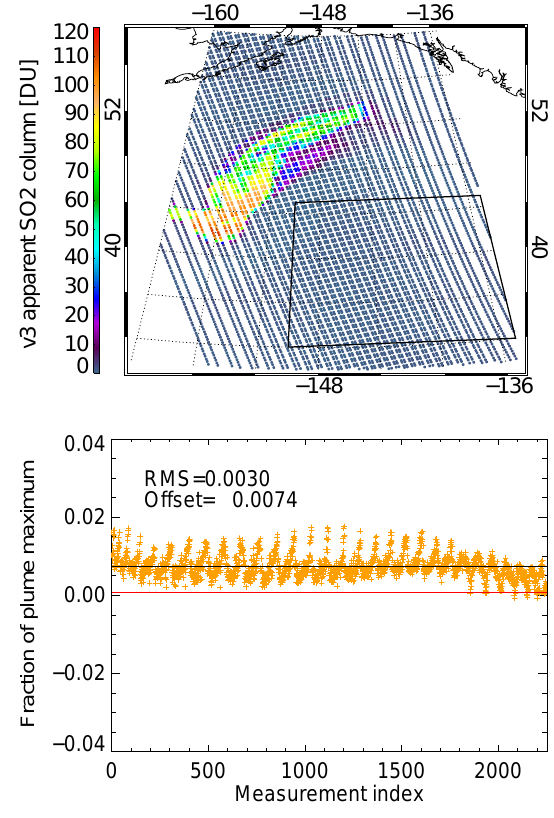
Fig. 5. The plume of SO 2 for the morning overpass on 10 Au- gust 2008 using the ν 1 band filter for Method (2) as described in the text using the ensemble approach to compute S tot (cid:15) . Fractional varia- tion in the background normalised according to the maximum value within the plume (328DU) shown in the bottom panel for IFOV’s inside box. Reported 1 σ sensitivity ( σ c ) for this filter of 0.0024 (=0.812DU). Observed RMS of background=0.0024. Expected climatological value shown as red line. Mean value of background value shown as black line